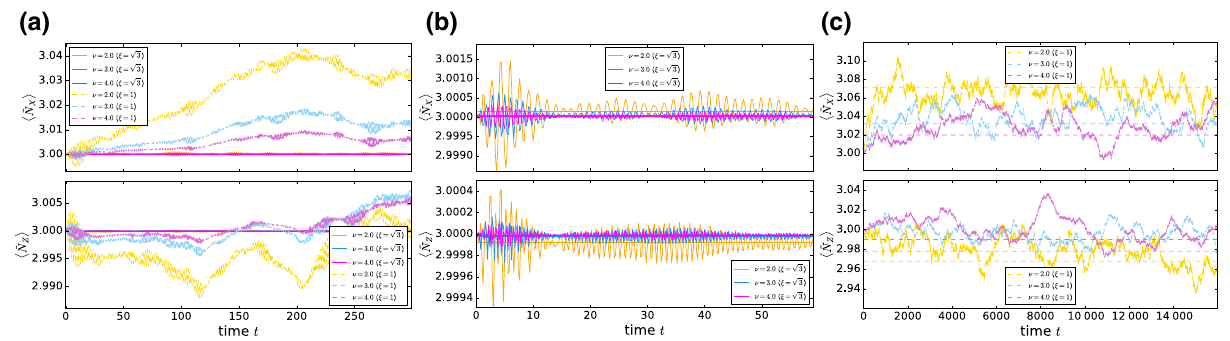
FIG. 4. The dynamics of the expectation values of the vertex and plaquette excitation operators (cid:6) ˜ N X (cid:3) (top panel) and (cid:6) ˜ N Z (cid:3) (bottom panel). (a) The dynamics of (cid:6) ˜ N X (cid:3) (top panel) and (cid:6) ˜ N Z (cid:3) (bottom panel) from initial product states with ( (cid:6) ˜ N X (cid:3) , (cid:6) ˜ N Z (cid:3) ) = ( 3, 0 ) and ( 0, 3 ) , respectively, are shown from time t = 0 until t = 300. The parameters used in the plots are ( L x , L y ) = ( 2, 3 ) , J = 0.1, and g = 0.15. The yellow, blue, and magenta curves use parameters ν = ( 2.0, 3.0, 4.0 ) , respectively. The dashed curves use ξ = 1, while solid curves √ √ 3. The solid (dashed) horizontal lines indicate the diagonal ensemble averages (cid:6) ˜ N X ( Z ) (cid:3) for ξ = 3 (ξ = 1.0 ) . belong to ξ = √ DE 3 shown in (a) again for a smaller range of time t , i.e., t = 0, . . . , 60. As easily seen now, (b) We plot the data for the case ξ = = the expectation values (cid:6) ˜ N X (cid:3) and (cid:6) ˜ N Z (cid:3) display oscillating behavior around the diagonal ensemble averages (cid:6) ˜ N X , Z (cid:3) with (cid:6) ˜ N X (cid:3) DE DE (cid:3) = ( 2.999 92, 2.999 98, 2.999 99 ) for ν = ( 2.0, 3.0, 4.0 ) , respectively. On the qualitative ( 3.000 15, 3.000 05, 3.000 02 ) and (cid:6) ˜ N Z DE side, we note that with increasing factor ν , the oscillations become stronger. (c) We spotlight the behavior of (cid:6) ˜ N X (cid:3) and (cid:6) ˜ N Z (cid:3) for the case √ 3 detailed in (b), we now observe distinctively different behavior. The computed expectation of ξ = 1.0. Contrarily to the case ξ = values (cid:6) ˜ N X ( Z ) (cid:3) do not show any oscillations around their diagonal ensemble averages. Instead, we see a strong discrepancy between (cid:3) and (cid:6) ˜ N (cid:3) (cid:6) ˜ N . To give the eye a guide line we again include the diagonal ensemble averages (cid:6) ˜ N X ( Z ) (cid:3) as dashed lines. X ( Z ) X ( Z ) DE DE = ( 3.071 46, 3.031 96, 3.019 63 ) and (cid:6) ˜ N (cid:3) = ( 2.967 84, 2.977 93, 2.989 82 ) for ν = ( 2.0, 3.0, 4.0 ) , Their exact values are (cid:6) ˜ N X (cid:3) Z DE DE respectively. Thus, the presented numerical data shows that emergent U(1) × U(1) symmetry persists to long times t for irrational ξ but not for integer ξ , consistent with the predictions of the theory of